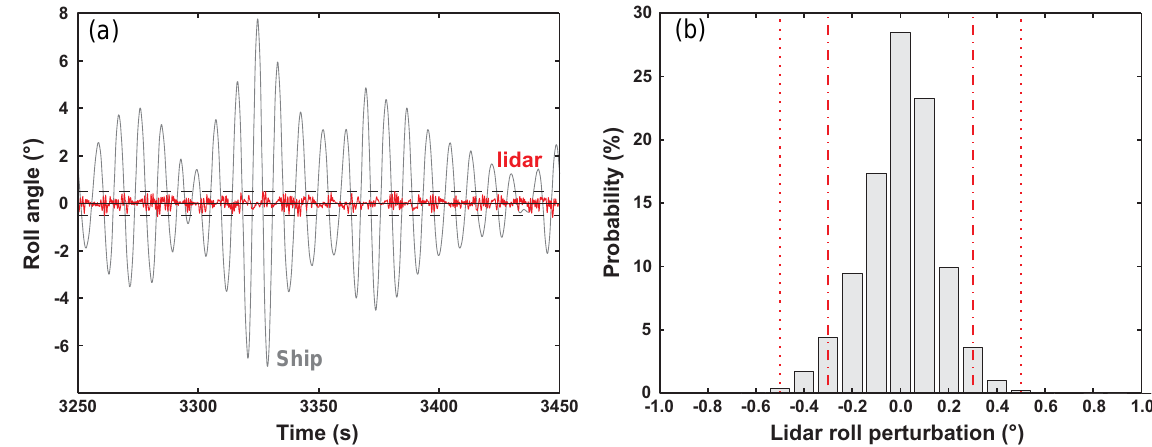
Figure 3. (a) Time series of ship and lidar roll angles on 18 September 2014 (05:54:10–05:57:30). Horizontal dashed lines indicate ± 0 . 5 ◦ . (b) Probability distribution of the lidar roll angle over the hour 05:00–06:00 on 18 September 2014. Red dotted lines indicate ± 0 . 5 ◦ ; dot- dashed lines indicate ± 0 . 3 ◦